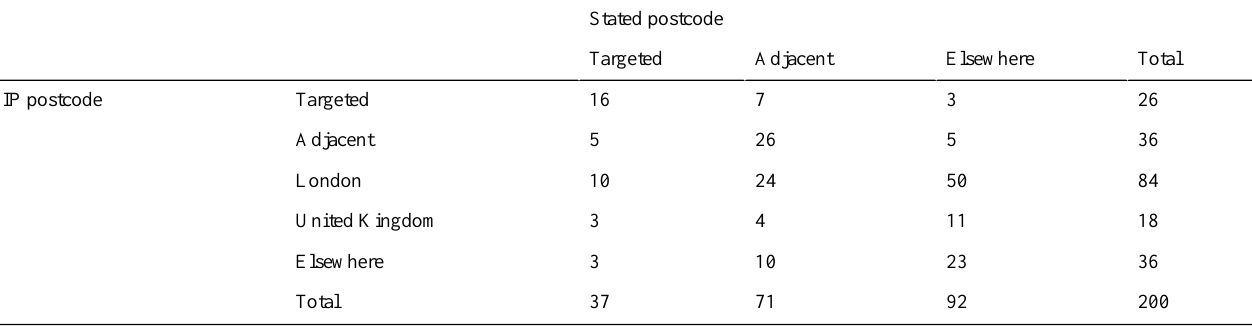
Table 4. Comparison of IP data with stated postcodes for a subsample of 200 visitors who completed our website questionnaire, including postcode area, between September 1 and 10,